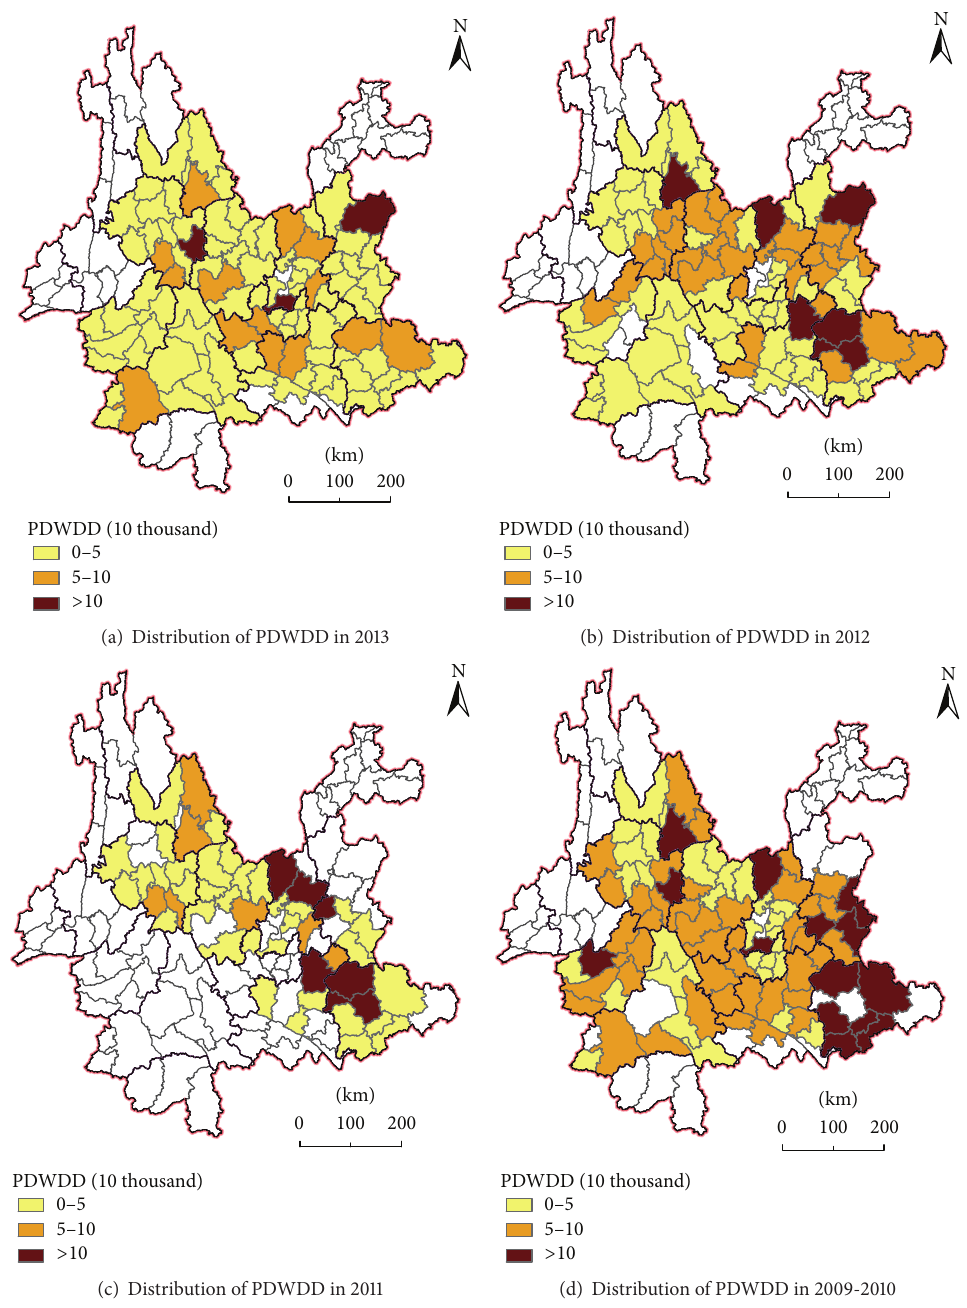
Figure 7: Distribution of populations in drinking water access difficulties because of drought of Yunnan province in